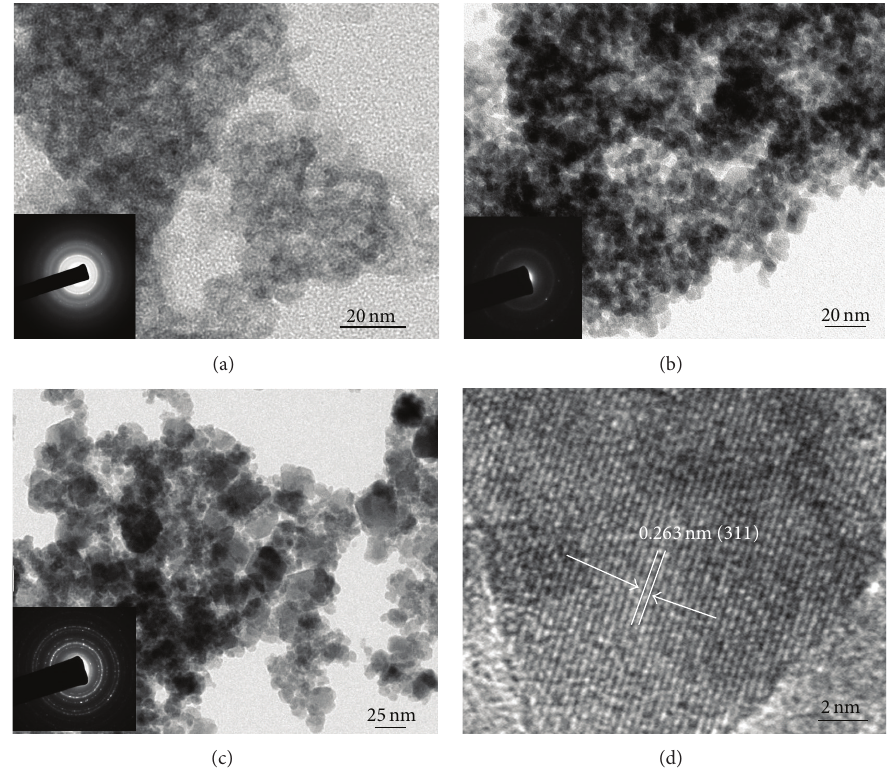
Figure 3: TEM images of (a) 4S, (b) 6S, and (c) 8S and (d) the HR-TEM image corresponding to (c). The SAED patterns are shown as an inset in corresponding TEM images.